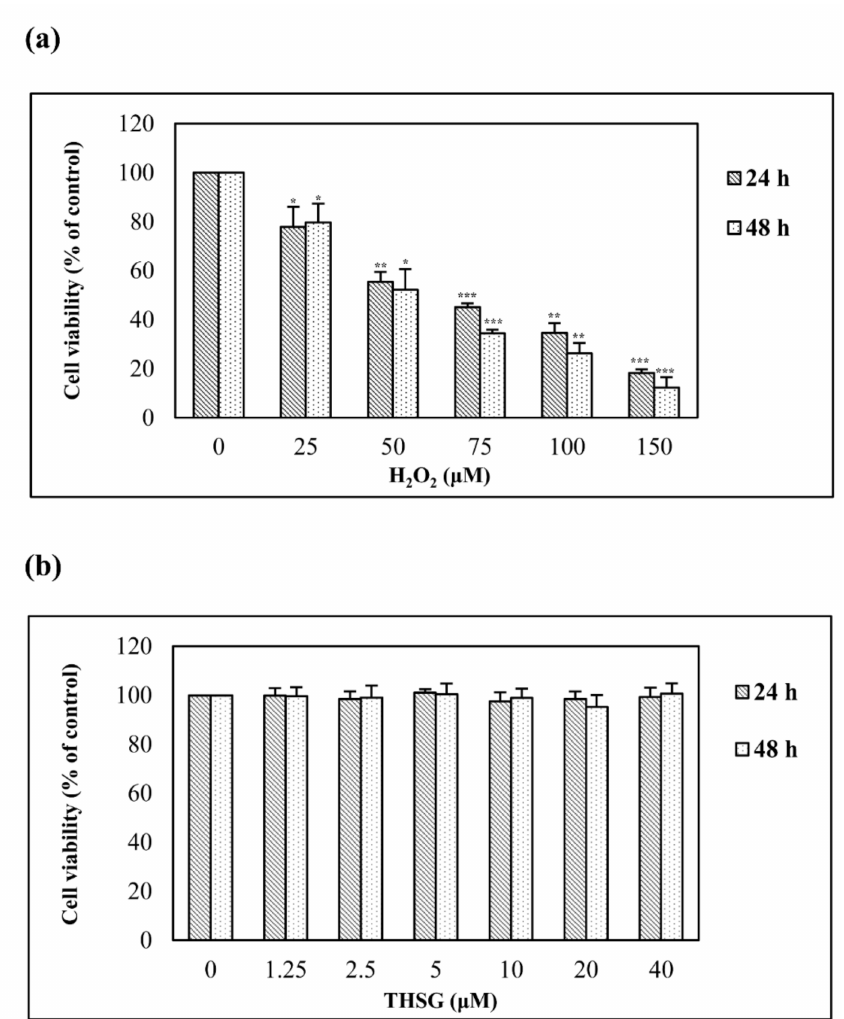
Figure 2. H 2 O 2 but not THSG reduces cell viability. The cells were treated with various concentrations of H 2 O 2 (0–150 µ M) ( a ) or THSG (0–40 µ M) ( b ) for 24 and 48 h, and their viability was determined using a 3-(4,5-dimethylthiazol-2-yl)-2,5-diphenyltetrazolium bromide (MTT) assay. The cell viability of untreated cells was set to 100%. Data are presented as the mean ± SD, n = 3. * p < 0.05, ** p < 0.01, and *** p < 0.001 indicate significant di ff erences compared with the untreated